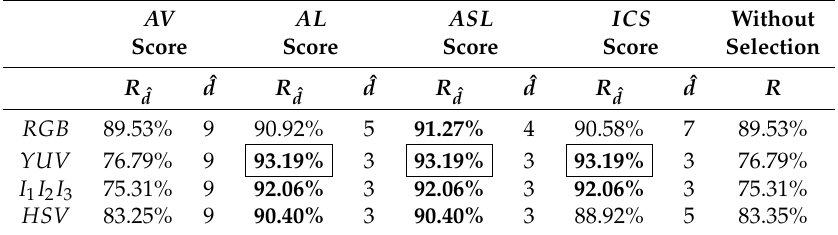
Table 3. Accuracy R ˆ (%) reached with the ˆ d -dimensional selected LBP histogram subspace, according d to the different supervised and unsupervised scores on the USPTex set (the dimension of the histogram space is D × Q = 9 × 256 without selection).